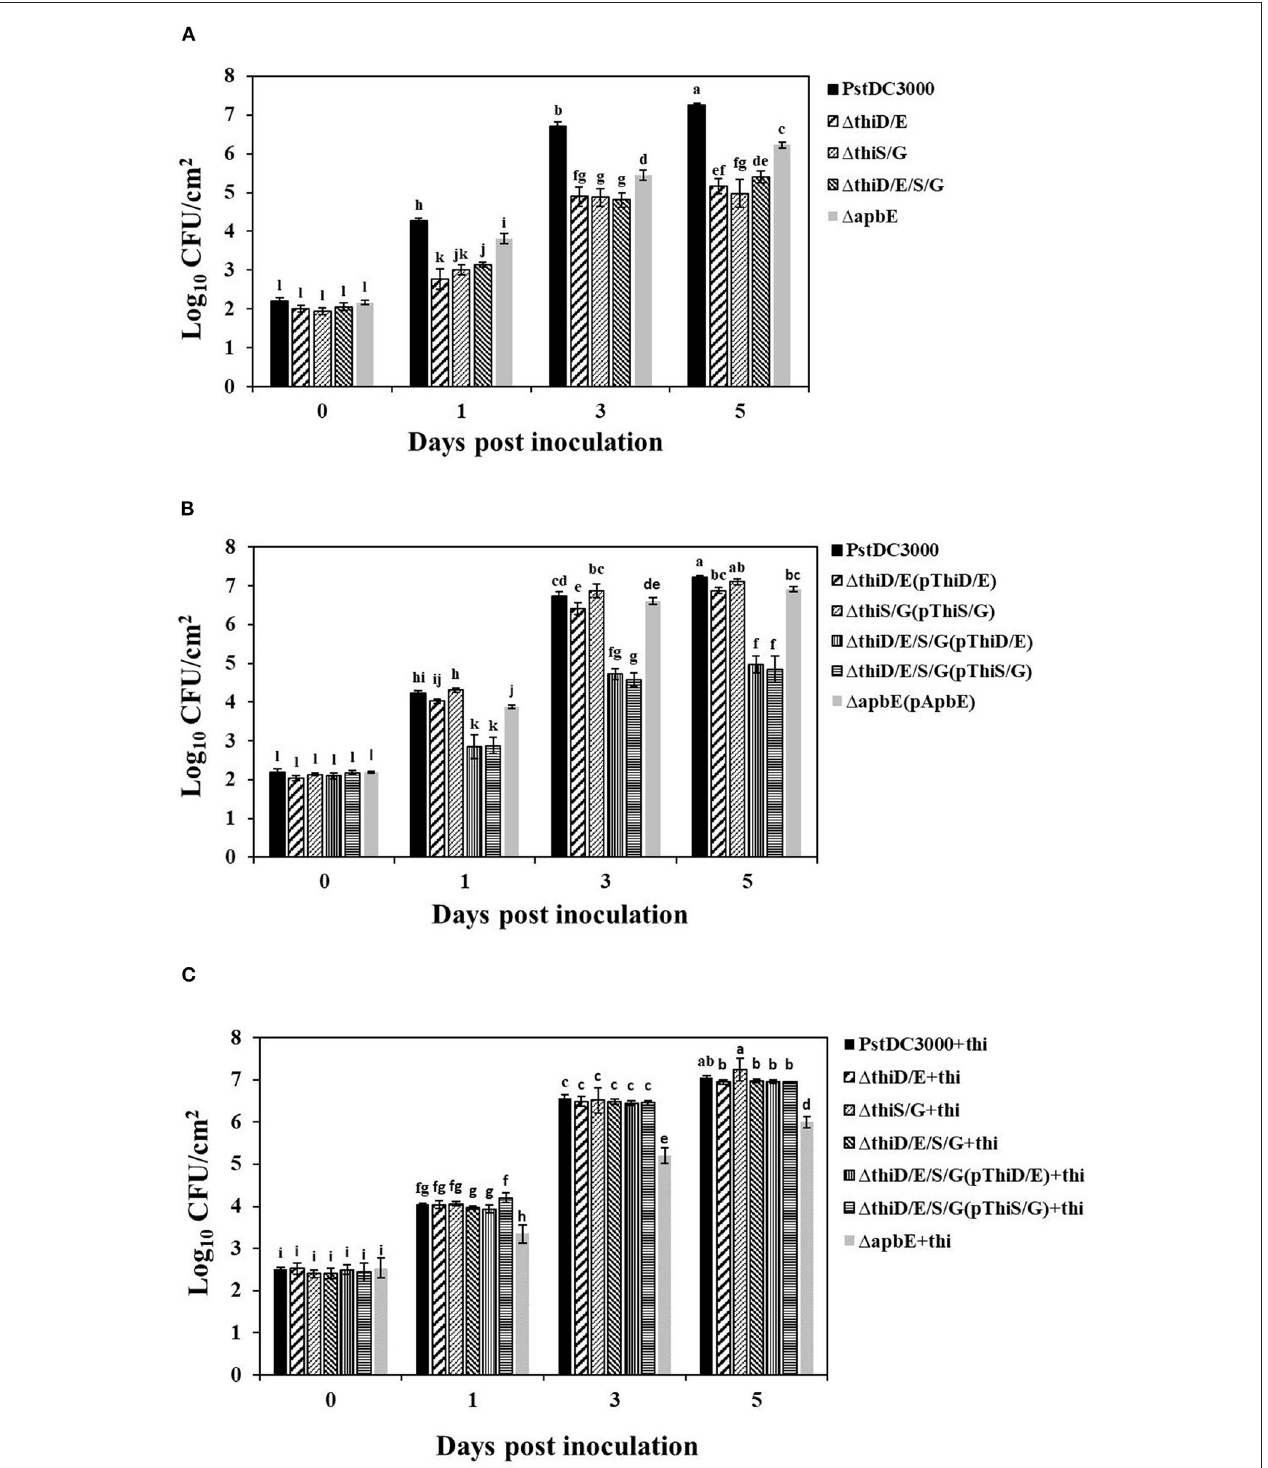
FIGURE 6 | Thiamine is required for bacterial growth of Pst DC3000 in tomato leaves. (A) Pst DC3000 wild type and the thiD/E , thiS/G , thiD/E/S/G , and apbE mutant strains. (B) Pst DC3000 wild type and all the complementation strains. (C) Pst DC3000 wild type and the thiD/E , thiS/G , thiD/E/S/G , and apbE mutants with exogenous 100 µ g/ml thiamine. Bacterial growth was monitored at 0, 1, 3, and 5 dpi. “ + thi:” added exogenous 100 µ g/ml thiamine. Each strain was inoculated onto 10 tomato leaves with a needleless syringe in each experiment. Experiments were repeated three times. Data represent the means of three replicates ± SDs (error bars). Different lowercase letters indicate a significant difference between the strains. Statistically significant differences were determined by one-way ANOVA and P -values were < 0.05.